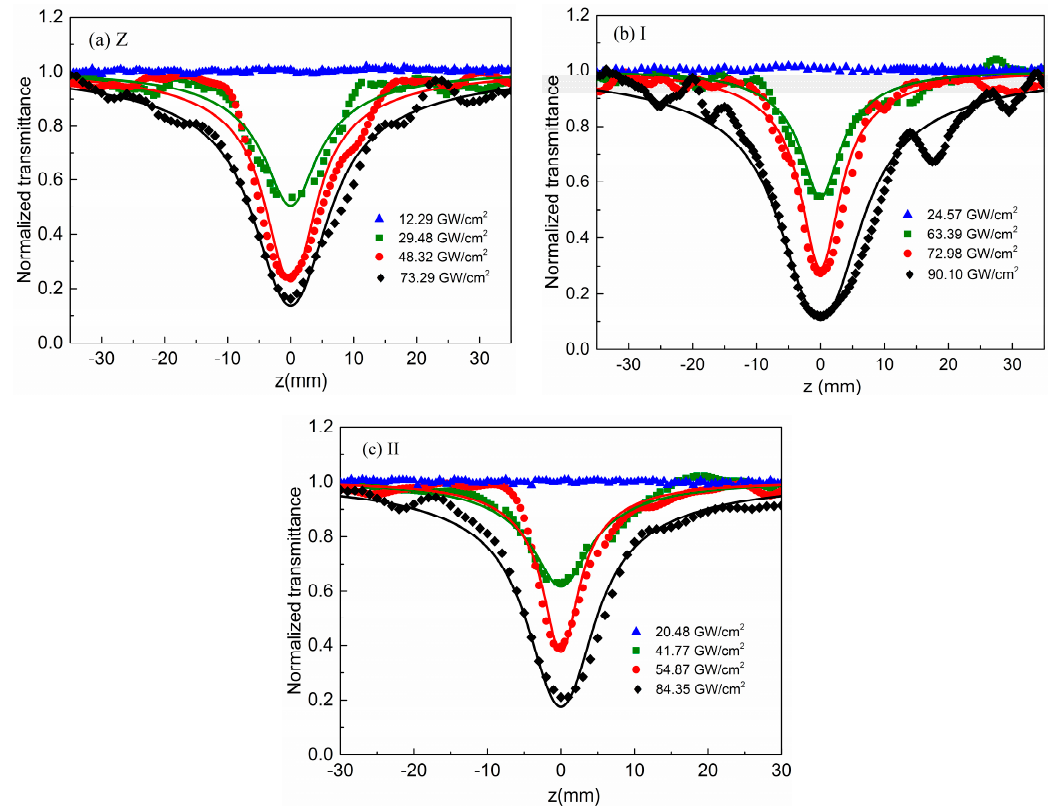
Figure 5. Open aperture Z-scan data and fitted curves for KDP samples with different intensities at λ = 532 nm: ( a ) z-direction, ( b ) I-type, ( c ) II-type.